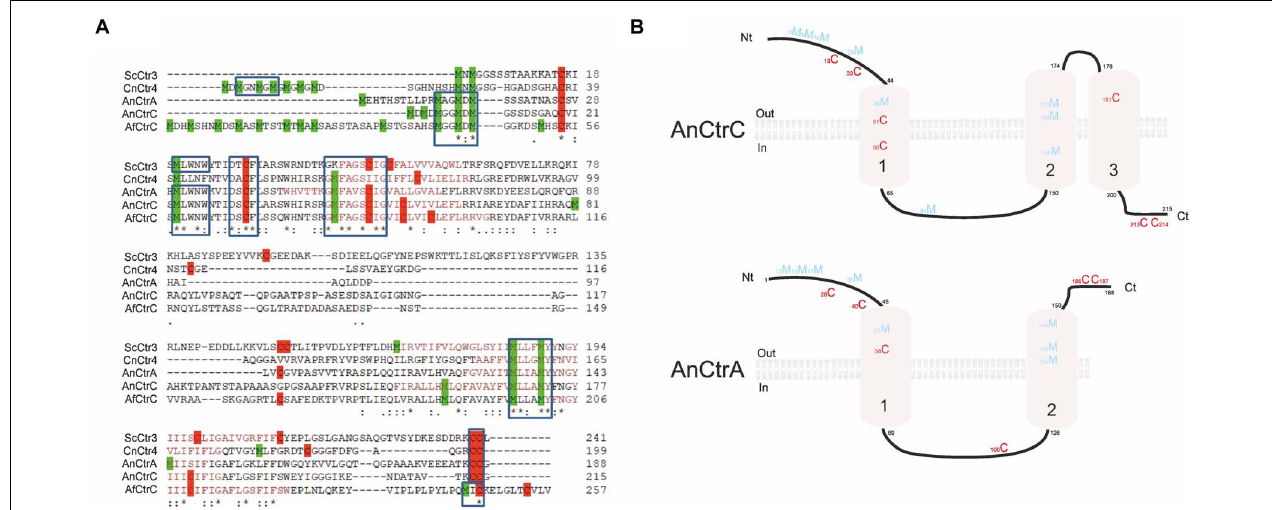
FIGURE 3 | Sequence analysis of Aspergillus nidulans high affinity copper transporters AnCtrA and AnCtrC. (A) Alignment of predicted full-length of Saccharomyces cerevisiae Ctr3, Cryptococcus neoformans Ctr4, Aspergillus nidulans CtrA and CtrC, and Aspergillus fumigatus CtrC sequences compared using the Clustal method. Identical residues are described with asterisk, and conservative and semi-conservative residues with double and single dots, respectively. Methionine residues are represented in green and cysteines in red. The length of each protein is indicated adjacent to the last amino acid. Protein accession numbers are reported as follows: ScCtr3 (Q06686), CnCtr4 (J9VLN4), AnCtrA (C8VIA1), AnCtrC (C8V6S8), and AfCtrC (Q4WHY8). (B) Proposed model of AnCtrA and AnCtrC describing the predicted membrane topology and the conserved methionine and cysteine residues. AnCtrA contains two transmembrane domains and AnCtrC